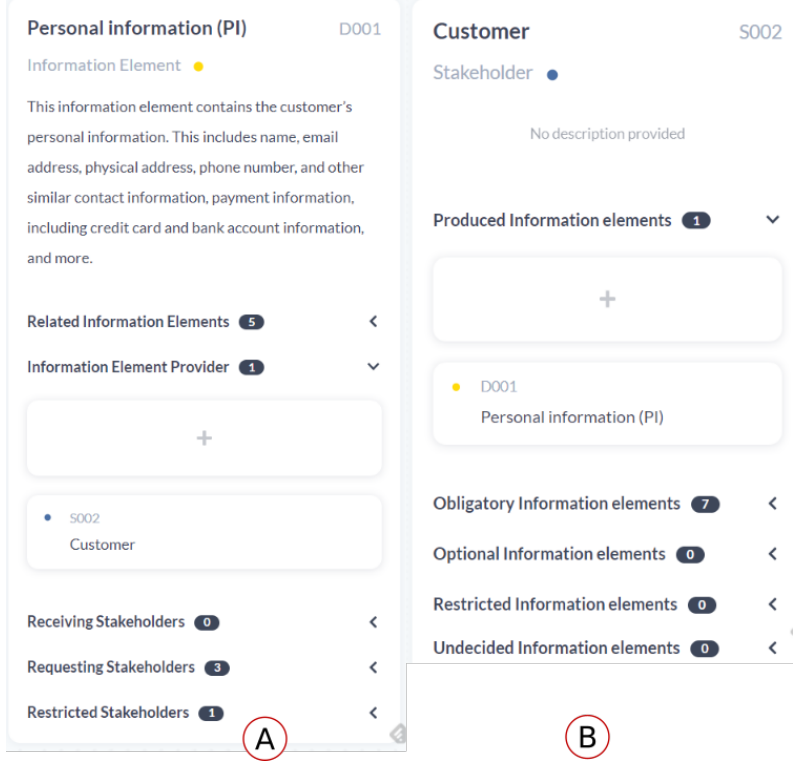
Figure 4. ( A ): AWS Infolet related to the keyword “Personal information”, ( B ): AWS SitReq related to